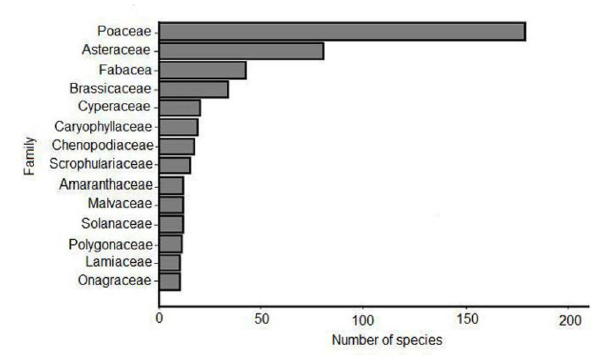
Figure 3. The number of species from the most common plant families with seed collected from